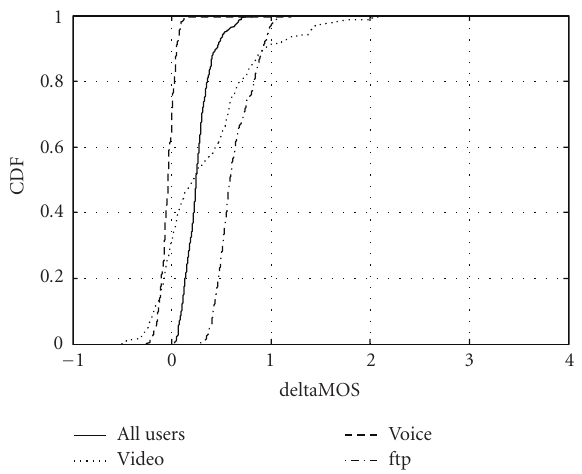
Figure 10: MOS gain per user, system symbol rate of 1500 Ksym- bol/s.